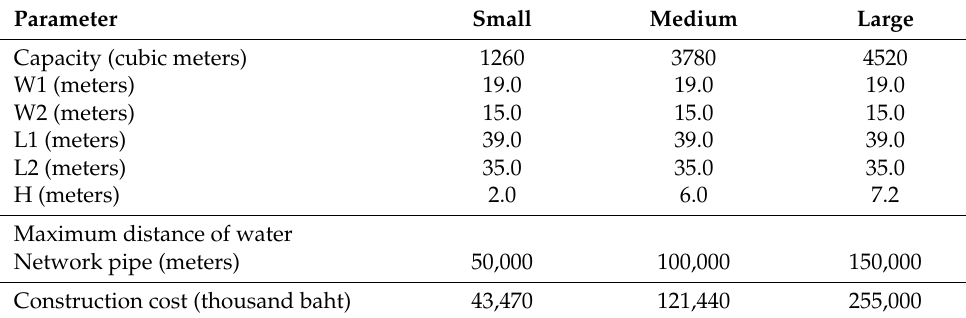
Figure 4. Diagram of the gravity flow system of the designed water supply. Table 2. Details of small and large community